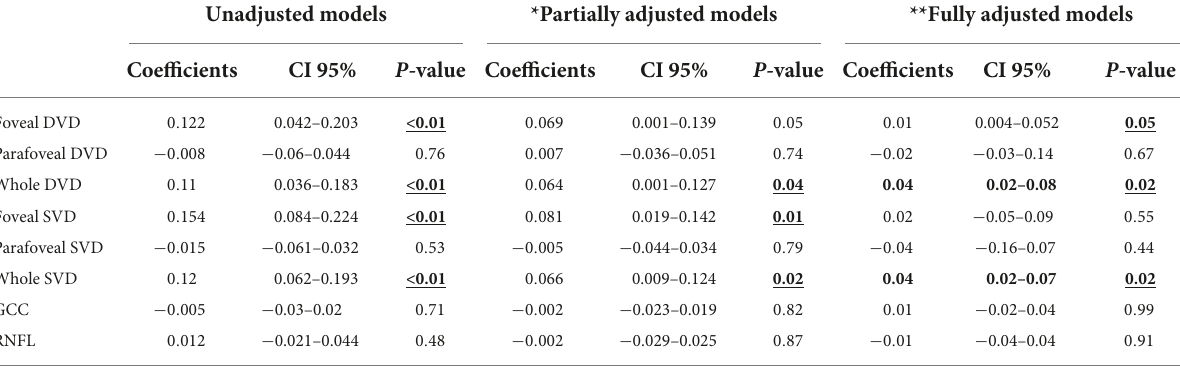
TABLE 2 Linear regression model on Mini-Mental State Examination (MMSE) as dependent variable and regressors. Unadjusted models